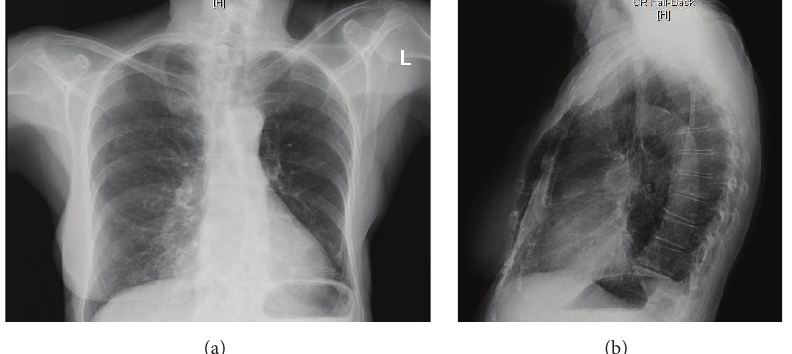
Figure 4: Chest X-ray findings in Case 4 . Chest X-ray shows prior left lower lobectomy, stable bilateral nodules, and new consolidation versus atelectasis of the